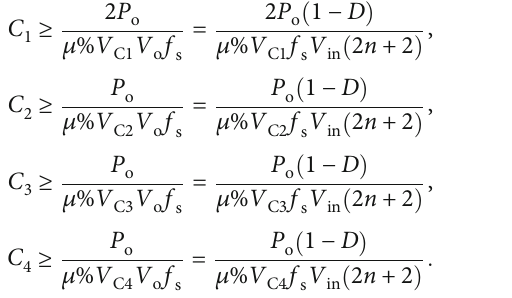
Table 4: Simulation